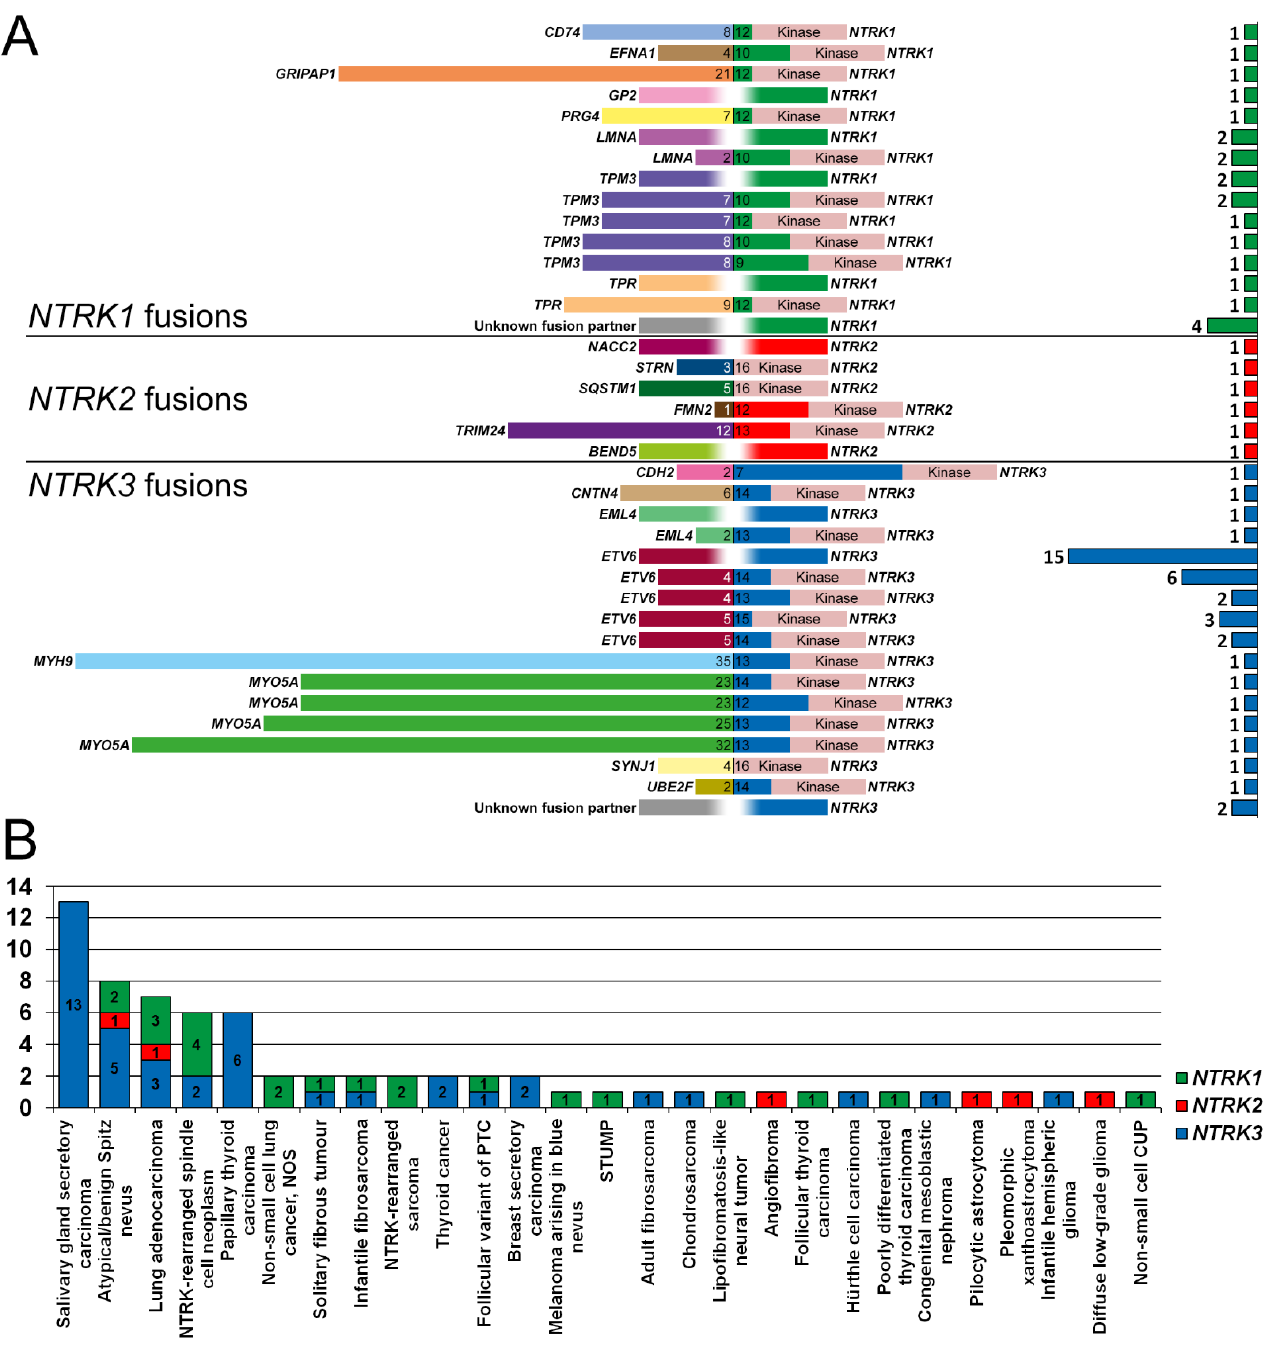
Figure 2. NTRK1-3 fusions identified in the Dutch population, 2017–2020. ( A ) Fusion partners and exonic breakpoints were identified in 69 patients with NTRK1 (green), NTRK2 (red), and NTRK3 (blue) fusions. The kinase domain is annotated and shown in pink. A blurred white breakpoint indicates that the exact breakpoint was not known or specified. At the right, a bar graph depicts the number of times the specific fusion gene was detected. ( B ) Frequency of NTRK1 (green), NTRK2 (red), and NTRK3 (blue) fusions and types of malignant or benign tumors. Abbreviations: CUP, cancer of unknown primary; NOS, not otherwise specified; PTC, papillary thyroid carcinoma, STUMP, Spitzoid Tumor of Uncertain Malignant Potential.